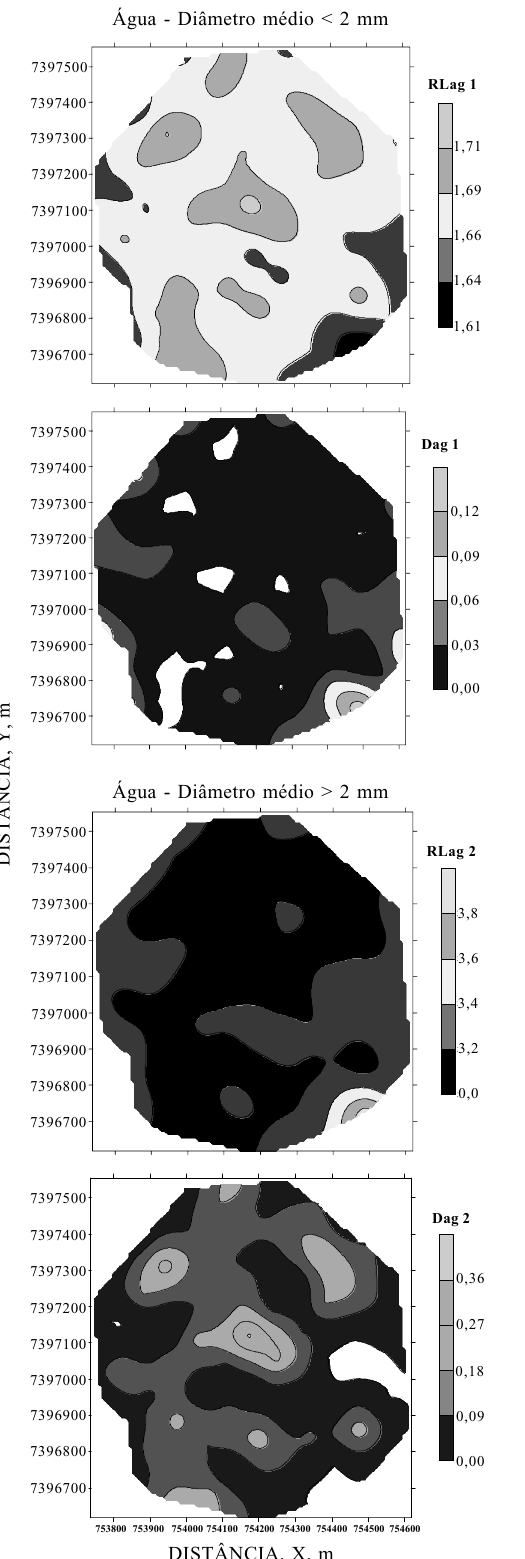
Figura 5. Mapa de contorno usando krigagem ordinária para o maior tamanho de agregado R e para a dimensão da massa fractal D no L pré-tratamento com